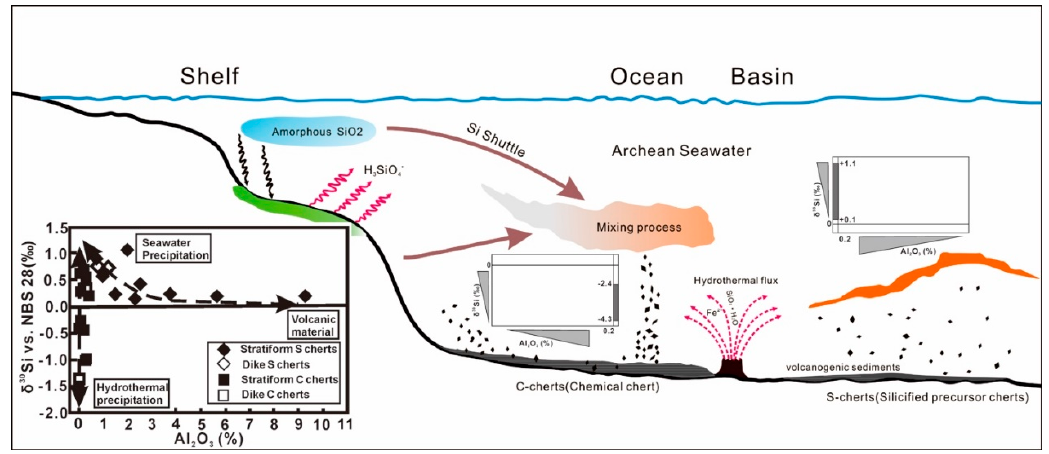
Figure 10. Schematic diagram for the metallogenic models of two typical BIF deposits (C-chert, S-chert). The insert shows the distribution pattern of δ 30 Si vs. Al 2 O 3 % among stratiform and dike C- and S-chert. Data compiled from van den Boorn et al. [109] and Swedlund and Webster [115].